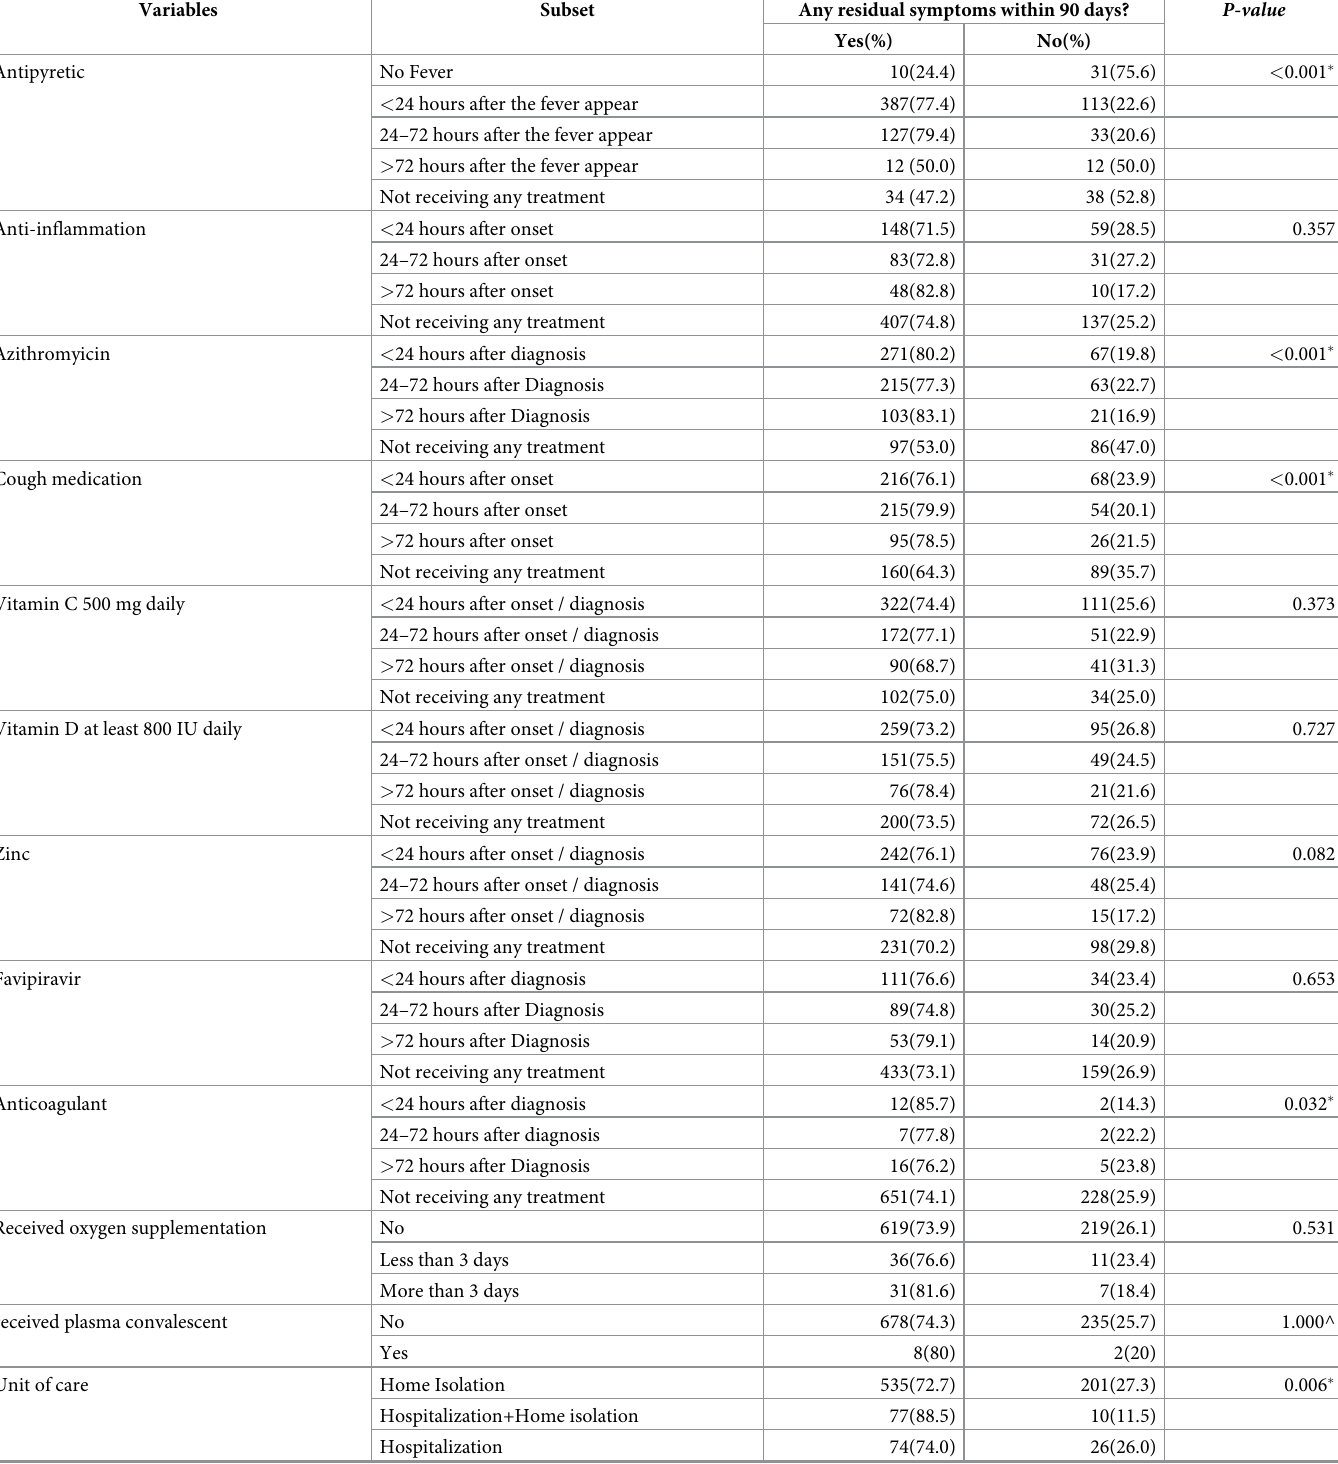
Table 2. Association between residual symptoms and received Covid-19 treatment within 90